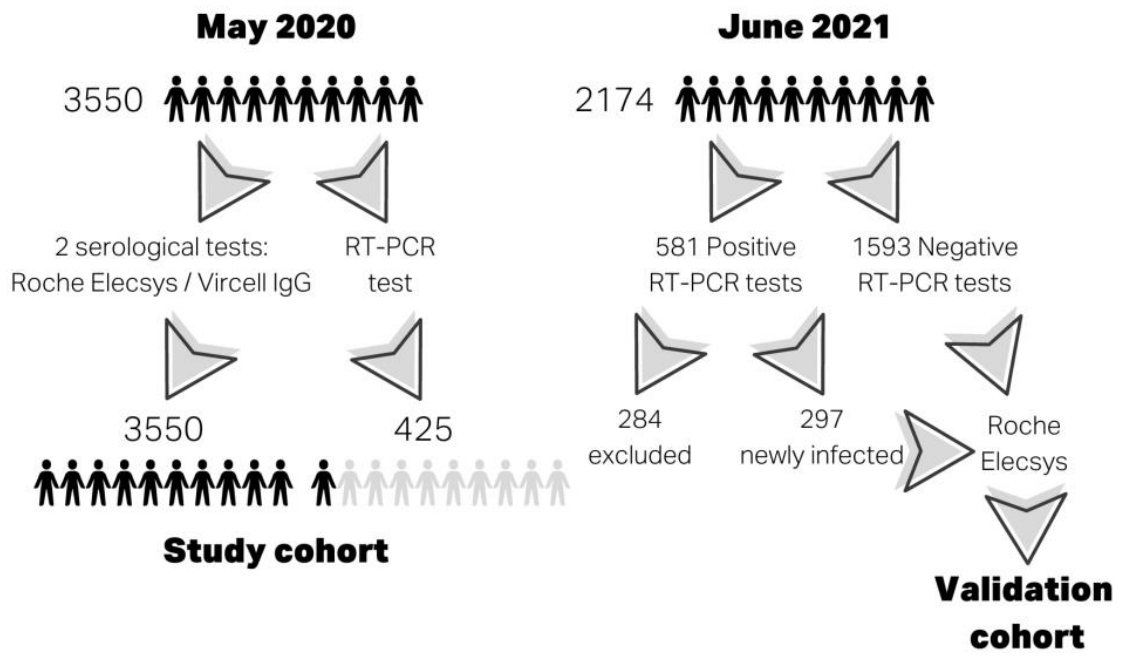
Figure 1. Definition of cohorts and tests performed. Table 1. Clinical data of healthcare workers from the study cohort ( n = 3550) .